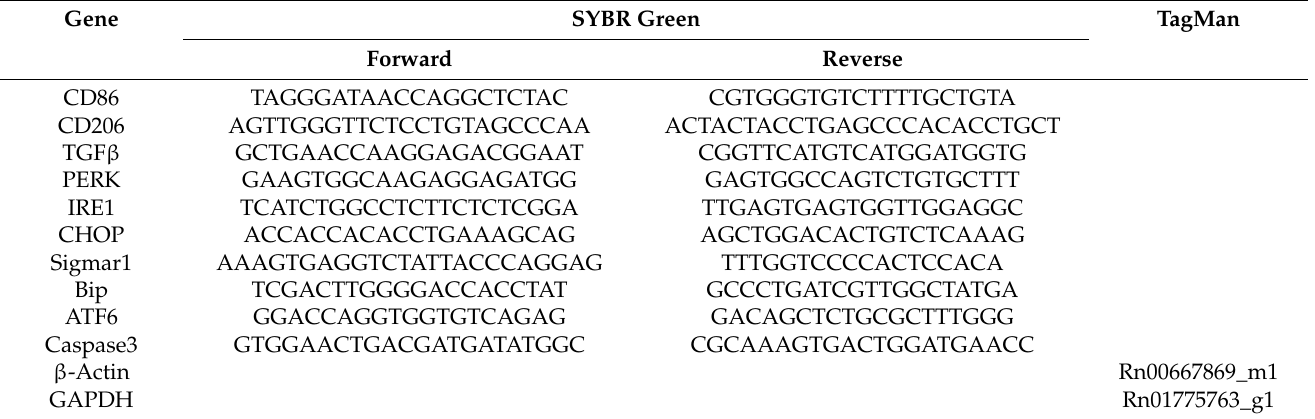
Table 2. Oligonucleotide primers used for quantitative